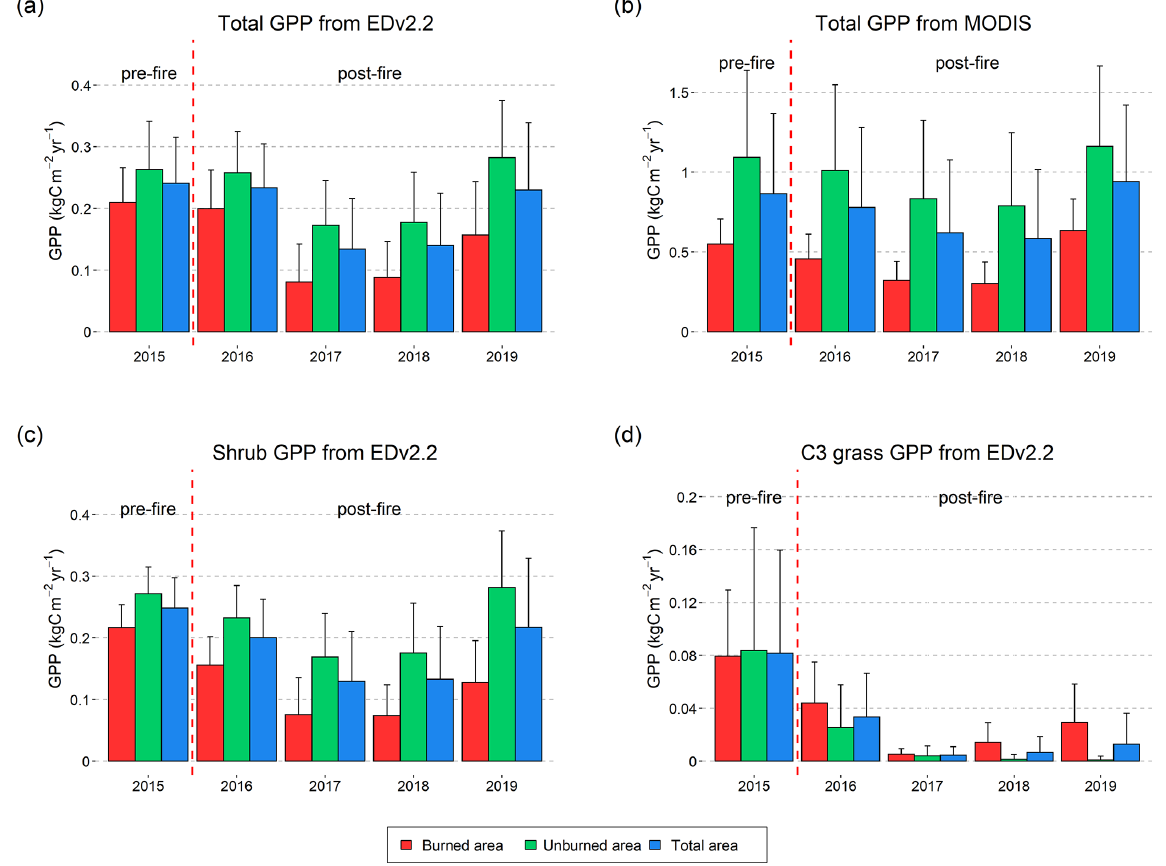
Figure 6. Average GPP from EDv2.2 and from MODIS calculated for all the burned (red), unburned (green), and total (blue) grids for annual July snapshot maps from 2015 to 2019 (a–b) . Average GPP from EDv2.2 for shrubs (c) and C 3 grass (d) . Error bars in the figure represent ± 1 standard